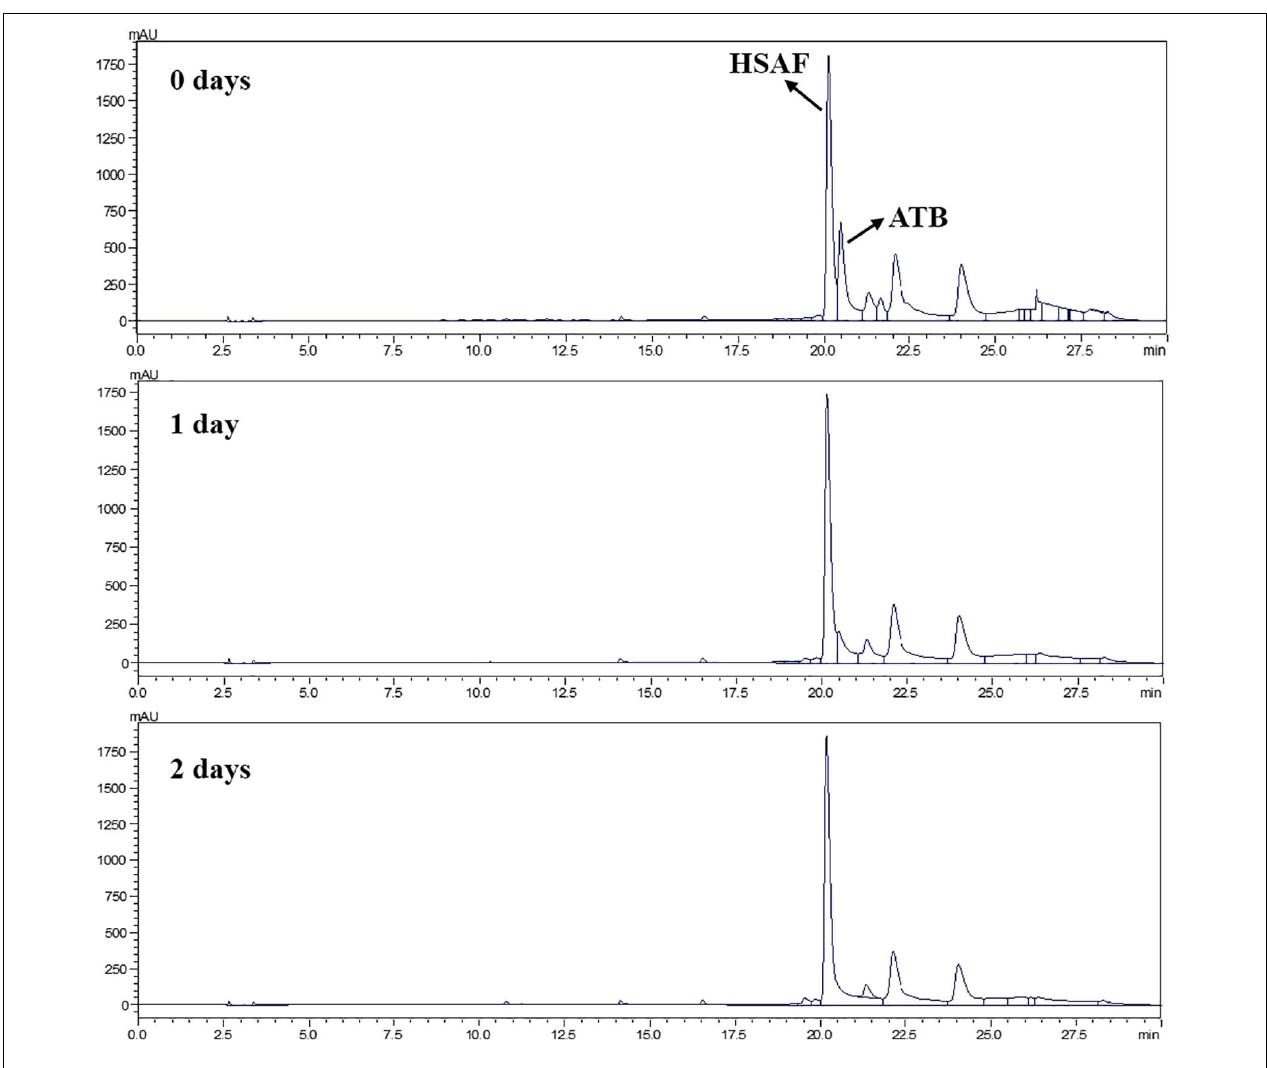
FIGURE 1 | HPLC chromatogram of HSAF and ATB after illumination for 2